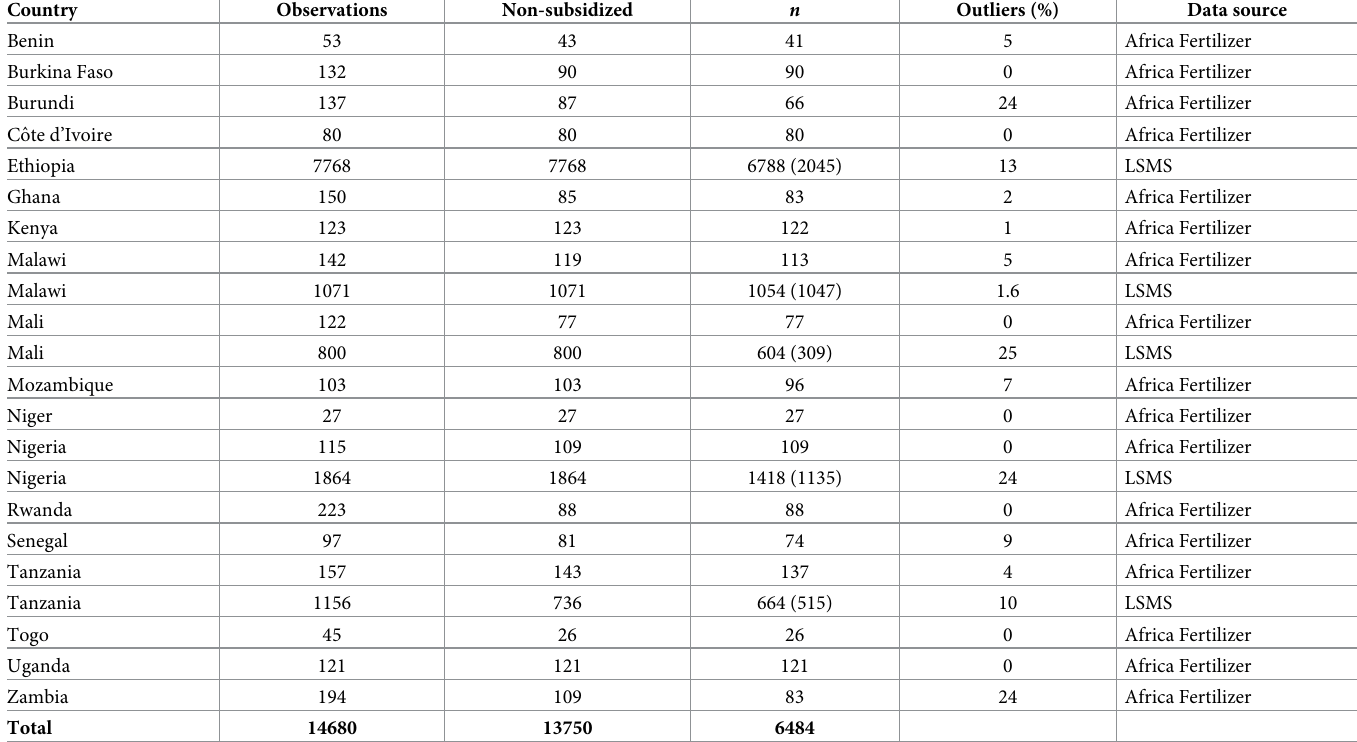
Table 1. Number of observations collected for urea prices, number of observations of non-subsidized urea, number of observations after removing outliers ( n ) and number of observations after aggregating by household (values between parenthesis), and the percent of outliers detected (%) for each data source. Country